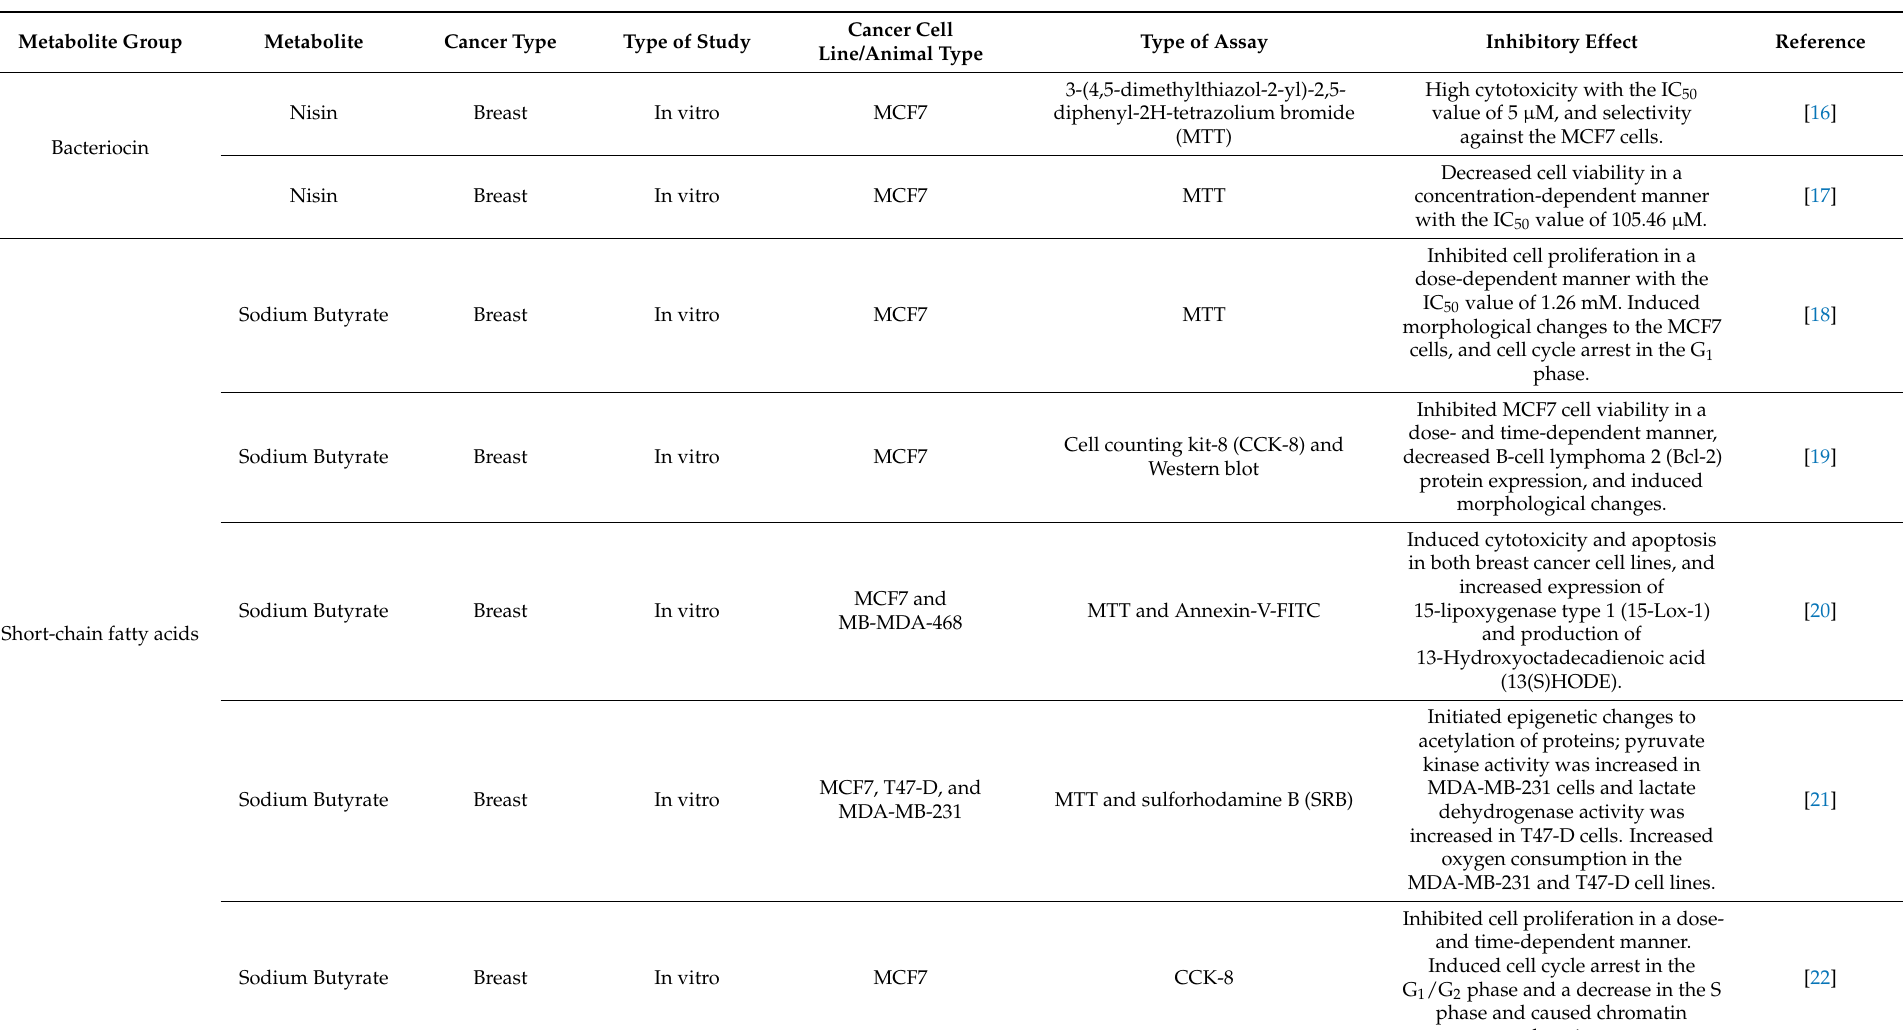
Table 1. A tabulated summary of studies assessing the anticancer activity of key gut metabolites in relation to breast